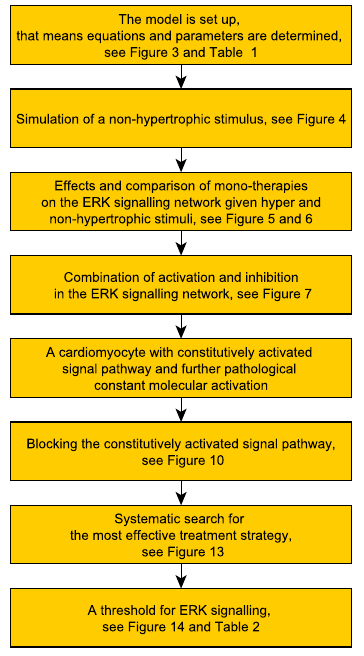
Figure 1. Flow chart of the